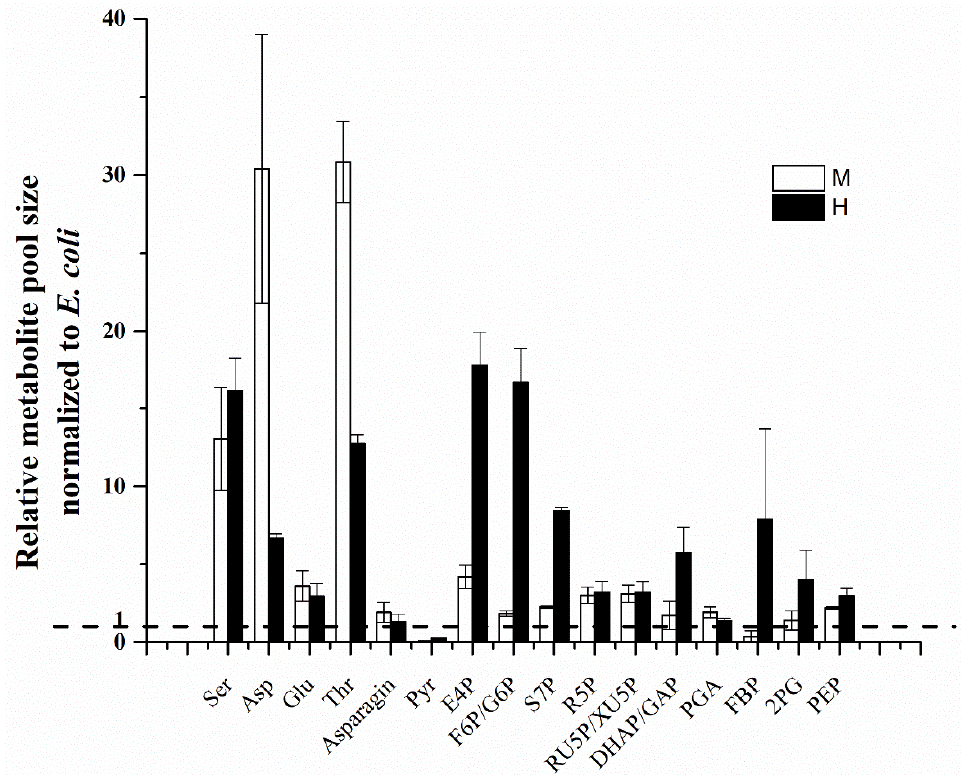
Figure 4. The relative pool size of C. sorokiniana normalized to E. coli K-12 under mixotrophic (M) and heterotrophic (H) conditions. A ratio of 1 indicates the same metabolite concentrations (normalized to gram biomass) in C. sorokiniana and E. coli .